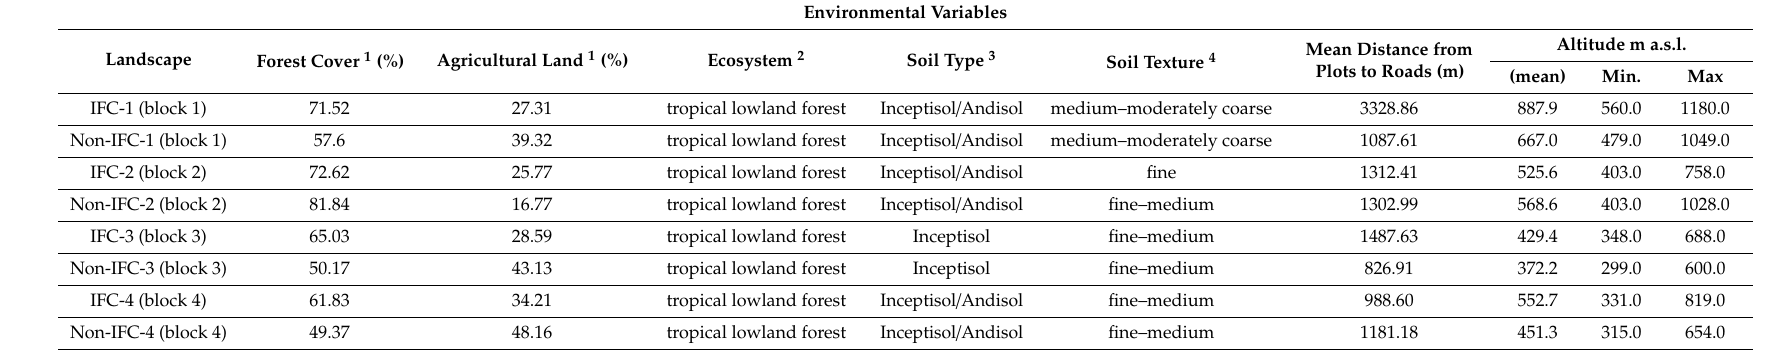
Table A1. Environmental variables considered for the block